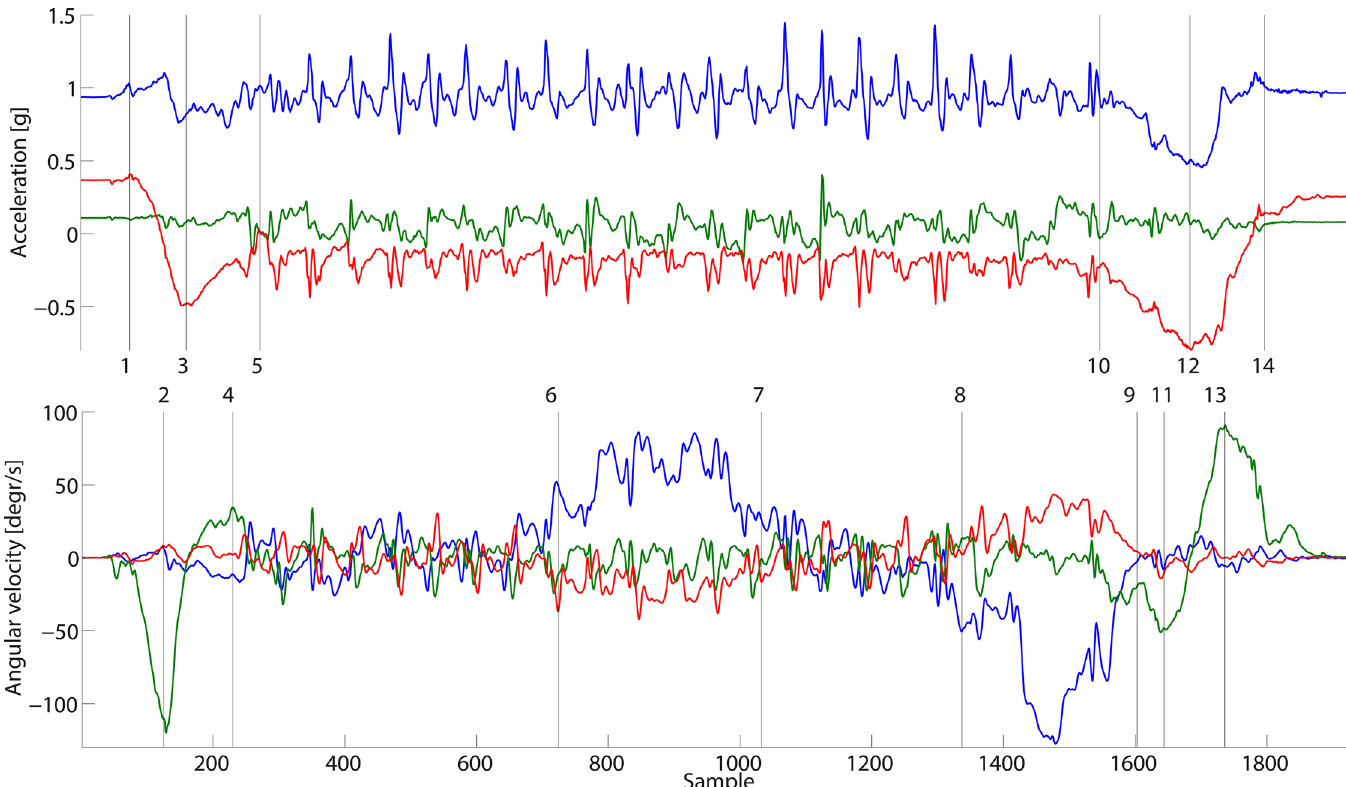
Fig 1. Raw data of the accelerometers on top and the gyroscopes at the bottom. 100 samples is one second. Blue are the vertical axes. green are the medio-lateral axes and red are the anterior-posterior axes. The numbers at the vertical lines correspond with the following events: 1 = Start SiSt. 2 = Maximum trunk flexion velocity SiSt. 3 = Maximum trunk flexion angle SiSt. 4 = Maximum trunk extension velocity SiSt. 5 = End SiSt. 6 = Start turn 1. 7 = End turn 1. 8 = Start turn 2. 9 = End turn 2. 10 = Start StSi. 11 = Maximum trunk flexion velocity StSi. 12 = Maximum trunk flexion angle StSi. 13 = Maximum trunk extension velocity StSi. 14 = End